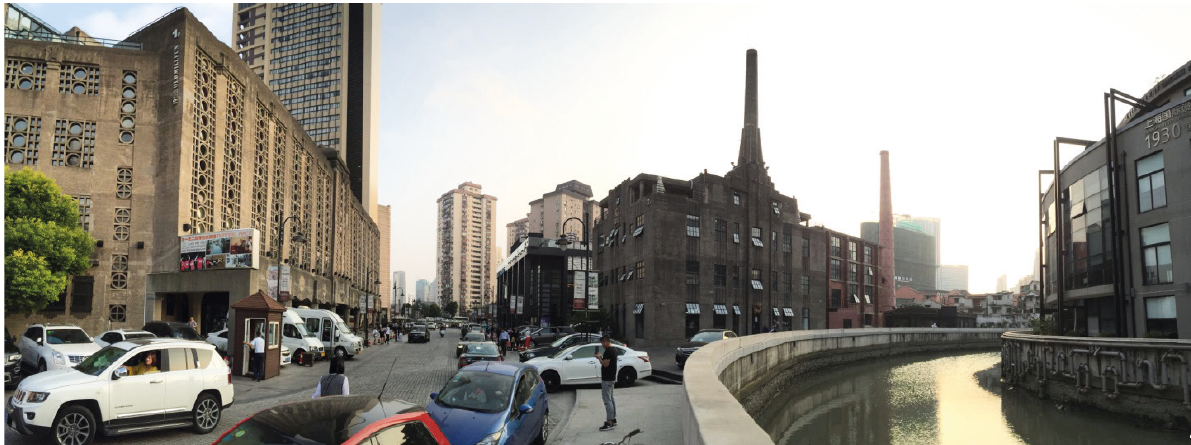
Figure 4 Shanghai Music Valley. (Source: the author,